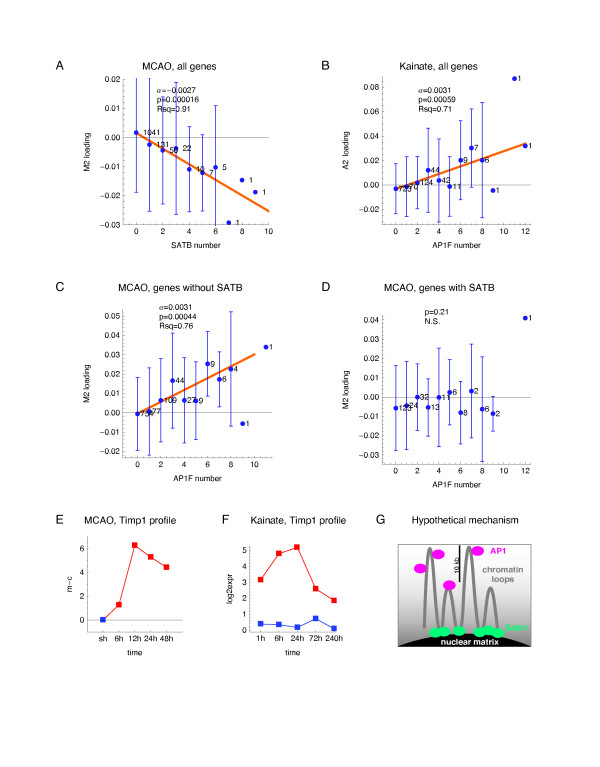
Effects of motifs binding AP1 and Satb1 on gene expression in the subspace of conserved eigensystem 2. The effects of motif count per gene on the loadings of the indicated eigensystem were analyzed by weighted linear regression. The response variable was the average loadings of a given eigensystem in groups of genes with the same count of the motif used as the regressor variable, with the weights equal to the numbers of genes per group. The average loadings for each motif count are indicated as blue dots, with their standard deviations shown as error bars, and the group gene count plotted next to each fitted data point. (A) The effect of SATB count on the loadings of eigensystem M2. (B) The effect of AP1F count on the loadings of eigensystem A2. (C) The effect of AP1F count on the loadings of eigensystem M2 analyzed for the genes without SATB motif. (D) The effect of AP1F count on the loadings of eigensystem M2 analyzed for the genes with SATB motif. (E-F) The log-expression profiles of Timp1 in the MCAO and kainate system. (G) A hypothetical mechanism, by which binding to the nuclear matrix via Satb1 makes a gene less accessible for binding or activation by AP1.